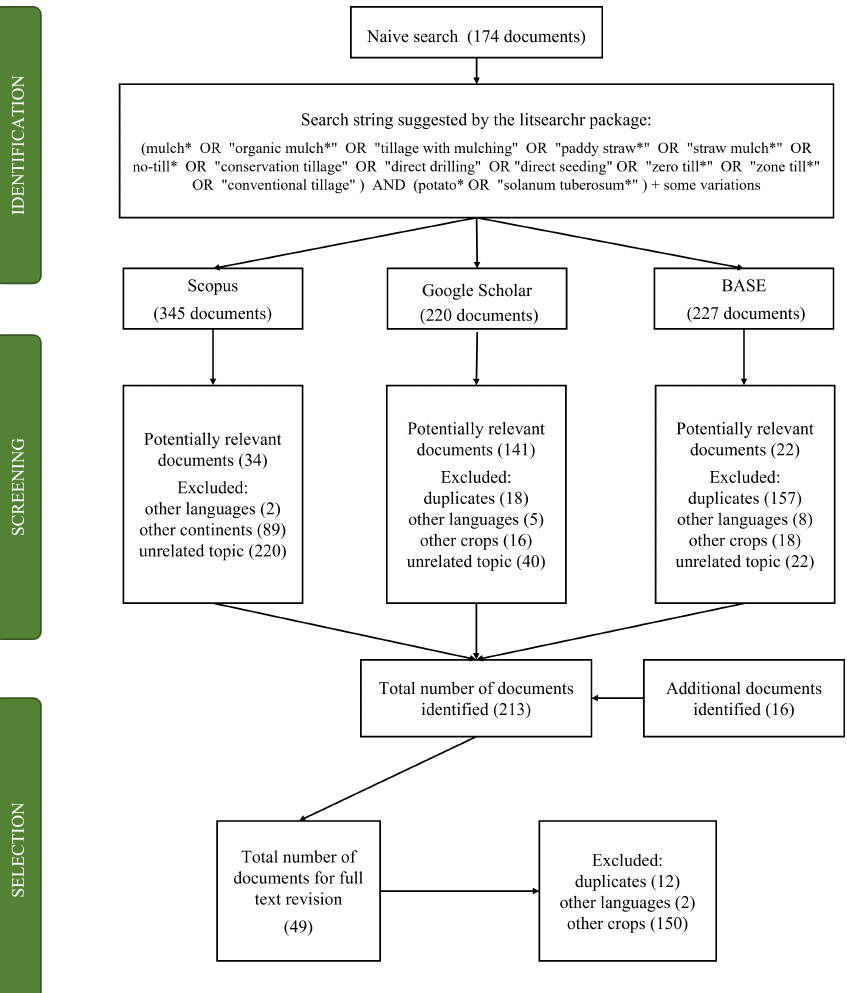
Figure 1. Flow diagram of the search methodology during 20–25 March